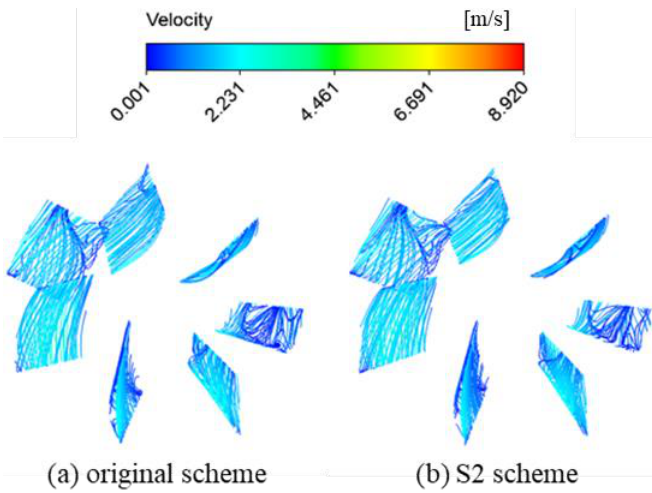
Figure 9. Streamline distribution of the guide vane surface for the S2 scheme and the original scheme.